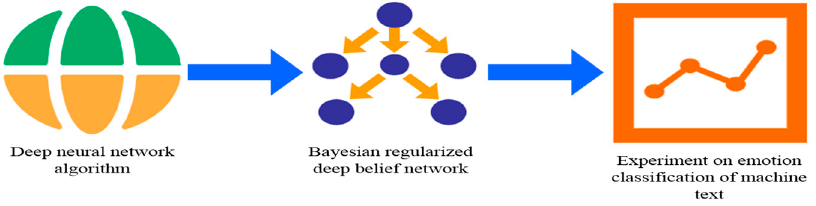
Figure 1. Overall